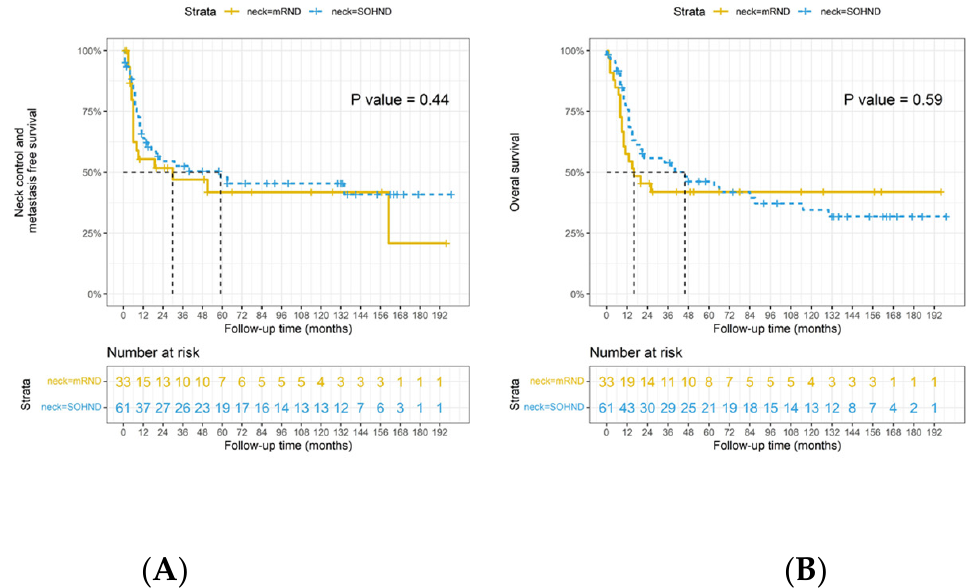
Figure 3. ( A ) Disease-free survival differences in extranodal extension+ (ENE+) by types of neck dissection (n = 94, p = 0.44); ( B ) overall survival differences in extranodal extension+ (ENE+) by types of neck dissection ( p = 0.59). Neck-control-distant metastases-free survival in extranodal extension+ (ENE+) by types of neck dissection. Dotted line indicated the survival time that half of the patients had no events.